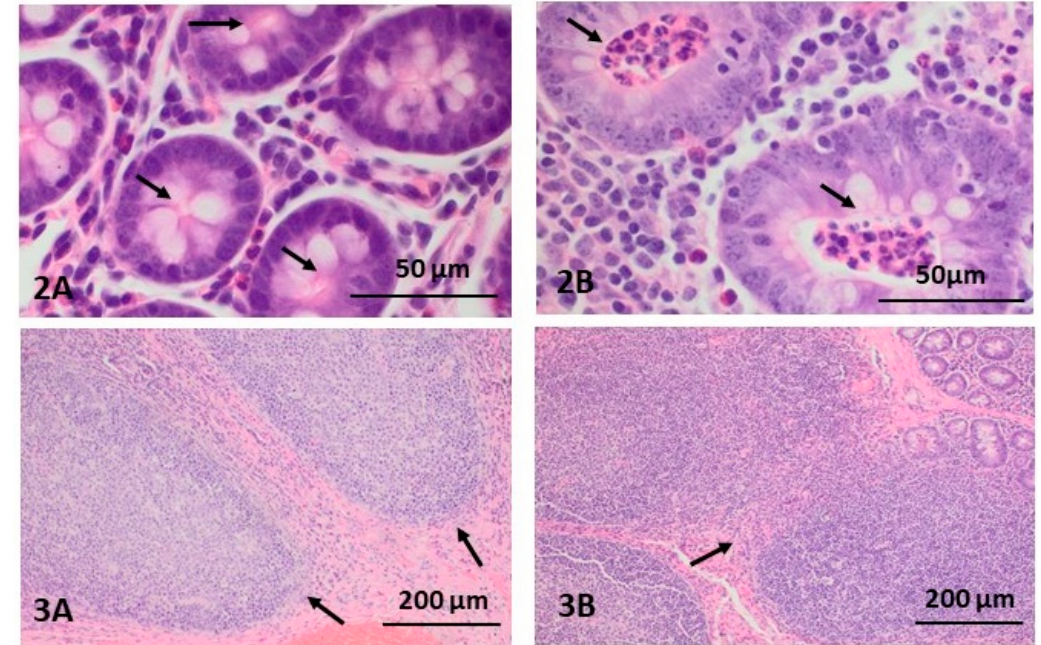
Figure 2. Histopathological staging of the ileum after administration of low (A) and high (B) doses of BPA: (1) less ( 1A ) and more numerous ( 1B ) eosinophils (indicated by arrows); (2) the lack ( 2A ) and the presence ( 2B ) of inflammatory cells in intestinal crypts (intestinal crypts are indicated by arrows); (3) the changes in the appearance of Peyer’s patches depending on BPA dose: Peyer’s patches in the LD group ( 3A ) and merged structures in the HD group ( 3B ) (Peyer’s patches are indicated by arrows).